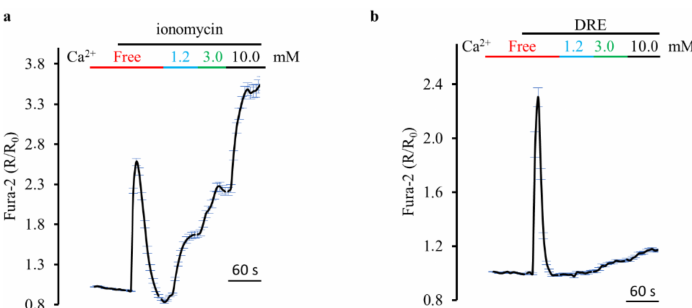
Figure 5. DRE does not act as an ionophore-like compound such as ionomycin. ( a ) Response of Fura-2-loaded HEK293 cells to the ionophore ionomycin (5 µ M) in the absence or presence (1.2, 3.0, and 10 mM) of extracellular Ca 2+ . The reported values are means ± SE from all the responsive cells on a single coverslip. ( b ) Response of Fura-2-loaded HEK293 cells to DRE (400 µ g/mL) in the absence or presence (1.2, 3.0, and 10 mM) of extracellular Ca 2+ . The reported values are means ± SE from all the responsive cells on a single coverslip.